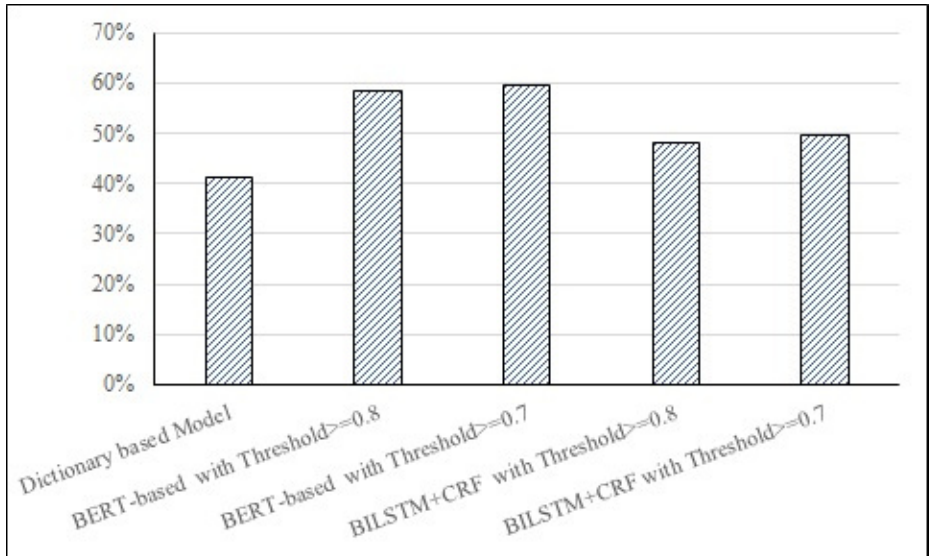
Figure 12. Chart showing the impact of the different entity-linked models on the percentage of scraped diseases interlinked with disease